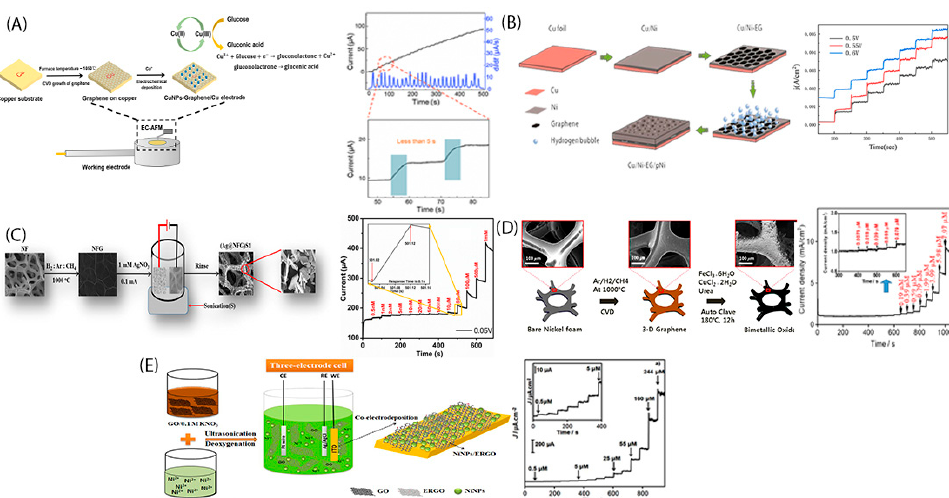
Figure 1. ( A ) CuNPs-graphene/Cu bioelectrode fabrication steps and its amperometric response to glucose injection [50]; ( B ) Synthesis procedure of Cu/Ni-EG/pNi, and the respective amperometric response to glucose injection [53]. ( C ) TEM images and amperometric response of Ag vertically deposited onto 3D nickel foam graphene and its amperometric response to glucose injection [54]; ( D ) Synthesis procedure of the CuFe-O/graphene onto nickel foam substrate and its amperometric response to glucose injection [41] and ( E ) Ni 2+ and Co co-reduction onto ITO for the Ni/rGO/ITO synthesis and its amperometric response to glucose injection [32].